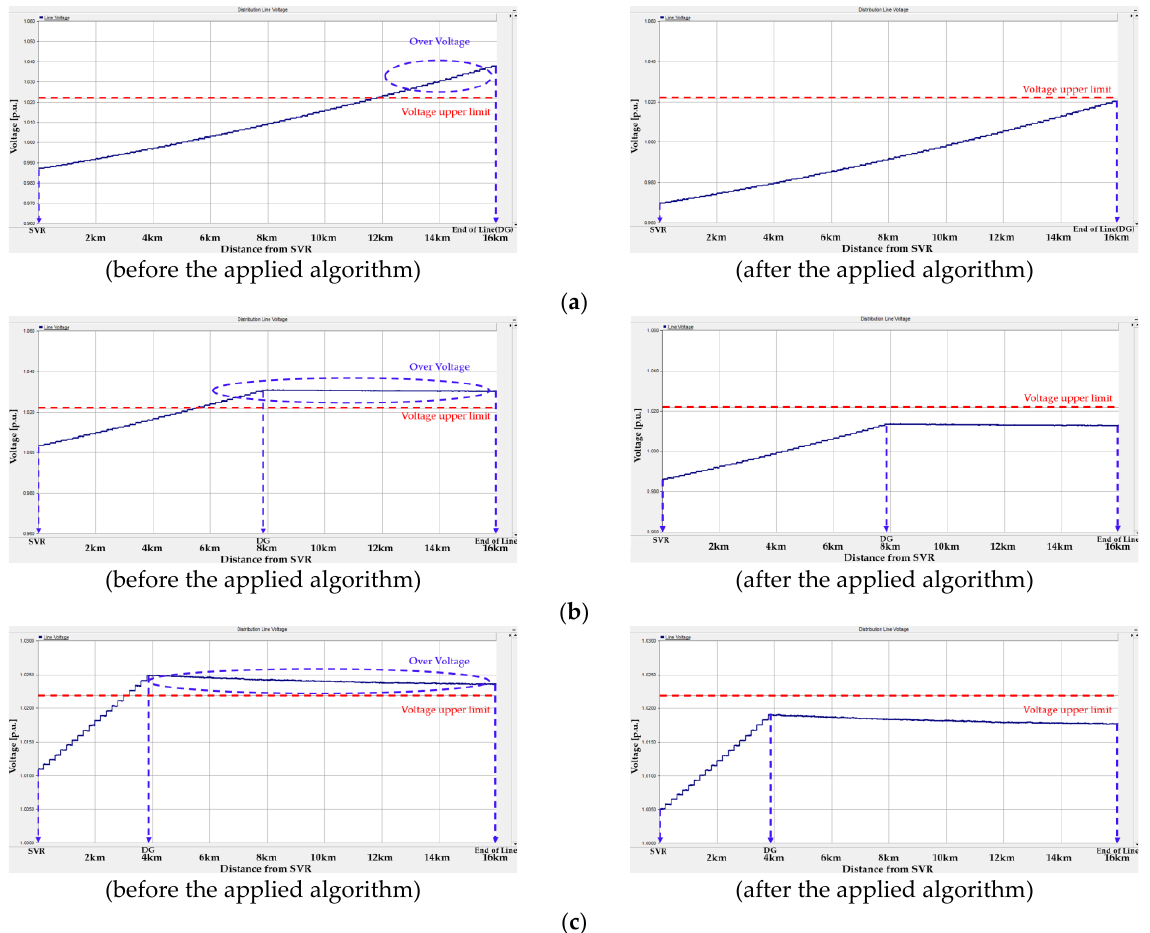
Figure 15. Distribution line voltage profiles by conventional and proposed voltage control Type 4: ( a ) Case I; ( b ) Case II; ( c ) Case III.